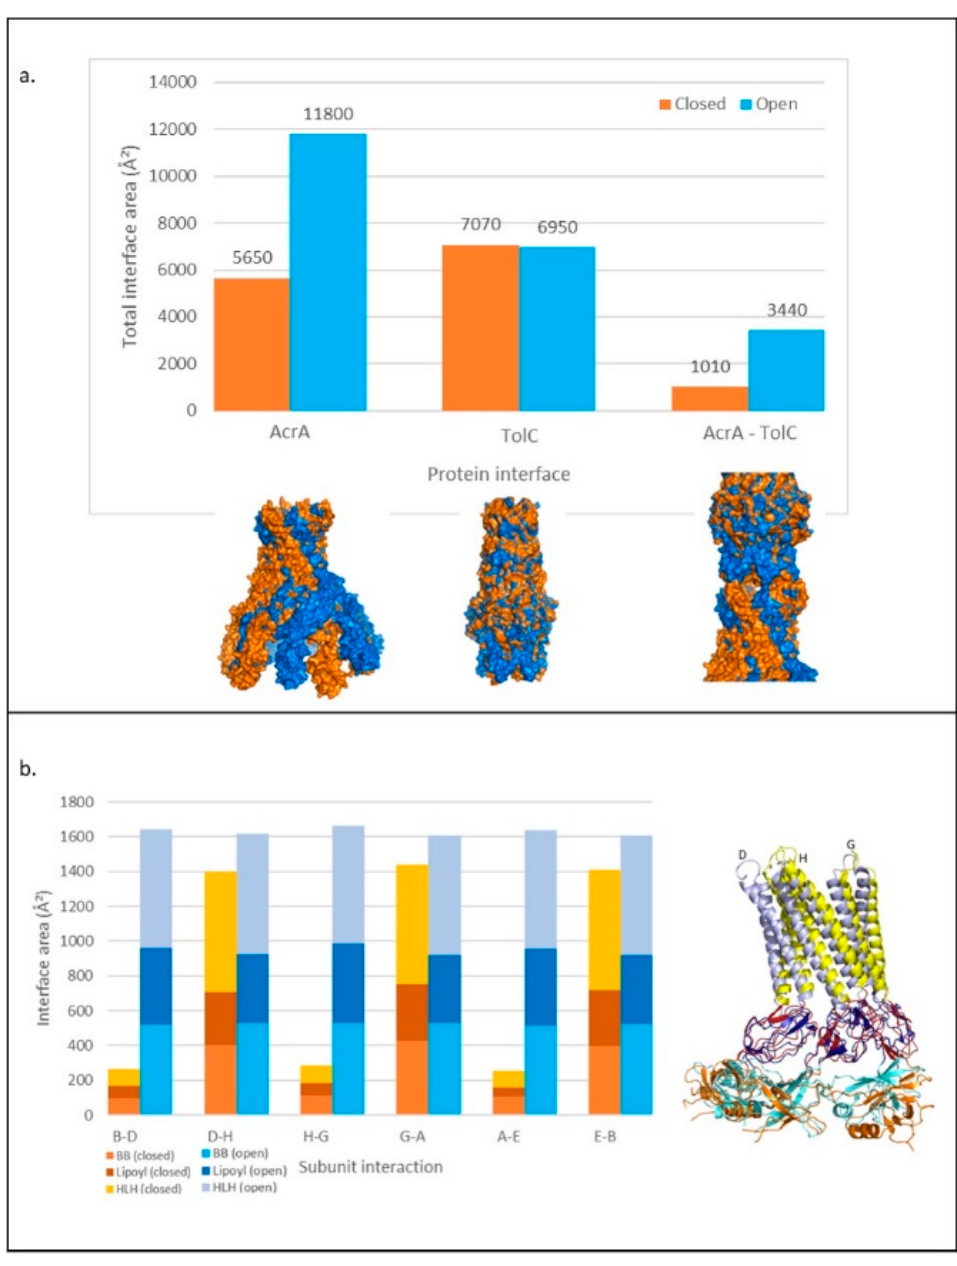
Figure 6 . Changes in the interface area within and between TolC and AcrA in transport and resting pump structures. ( a ) Above: Total interface area between subunits and proteins for TolC and AcrA calculated with PDBePISA to three significant figures. Below: Surface of aligned structures of proteins in closed (resting) (orange) and open (transport) (blue) states. ( b ) Left: Change in interface area between AcrA subunits in transport and resting states, showing the contribution of BB, lipoyl, and HLH domains. Right: Three AcrA subunits aligned in resting and transport states. Colours relate to domains on the bar chart. Subunit numbering from PDB: 5NG5. HLH: helix loop helix, BB: beta barrel.